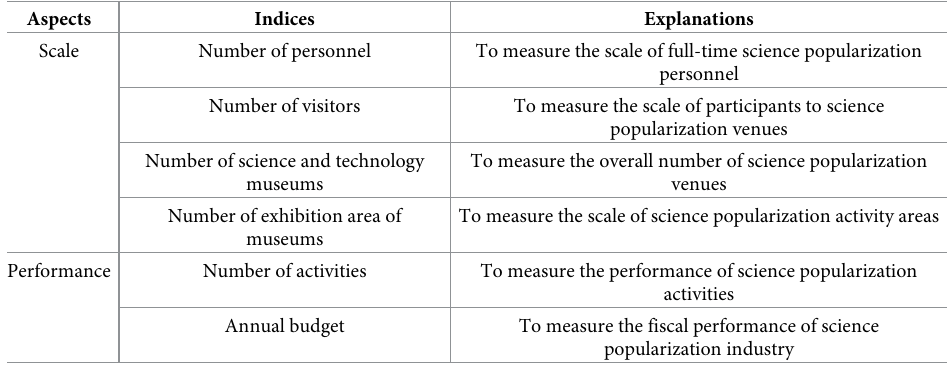
Table 2. Coordination assessment system for science